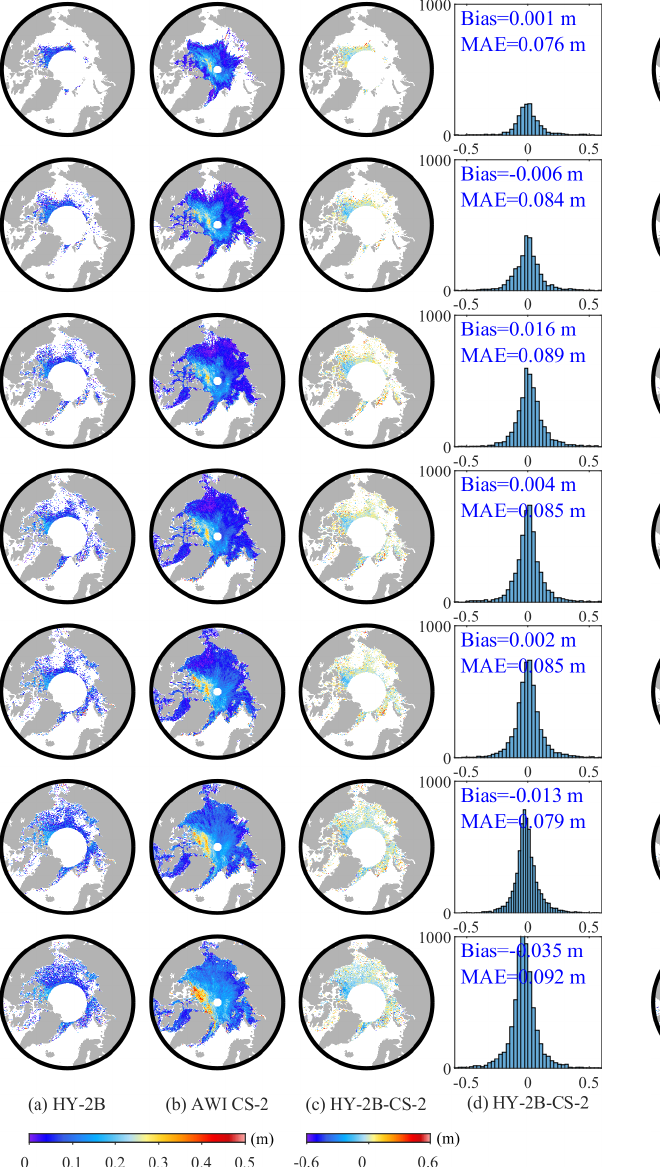
Figure 6. Comparisons and differences between HY-2B sea ice thickness and AWI CS-2 sea ice thickness from October 2019 to April 2020, (a) HY-2B sea ice thicknesses, (b) CS-2 sea ice thick- nesses, (c) spatial differences between HY-2B and CS-2 sea ice thicknesses, and (d) a histogram of the differences between HY-2B and CS-2 sea ice